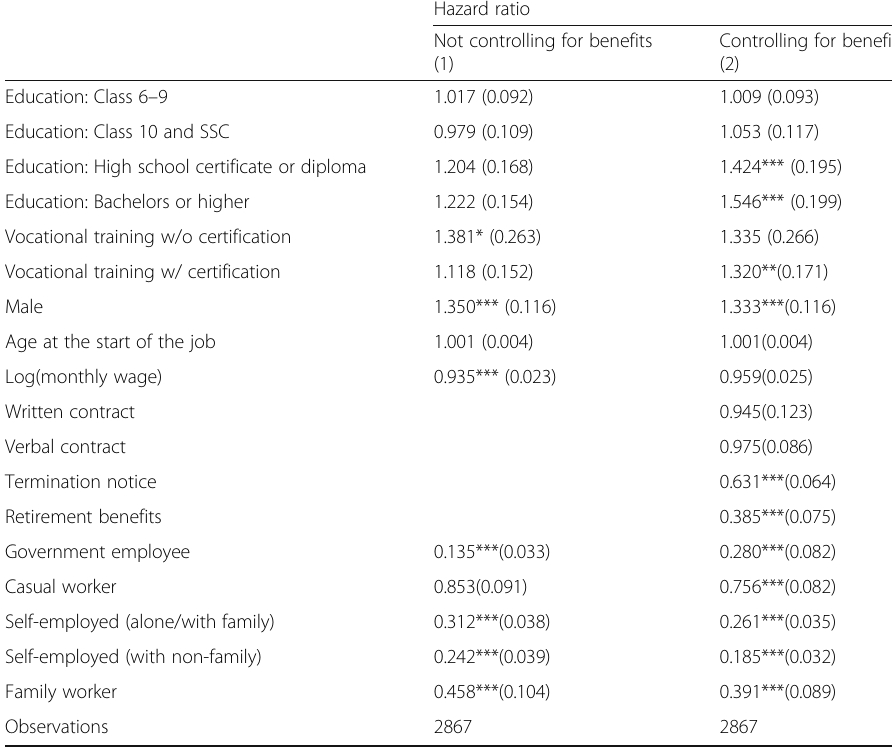
Table 8 Cox proportional hazards models